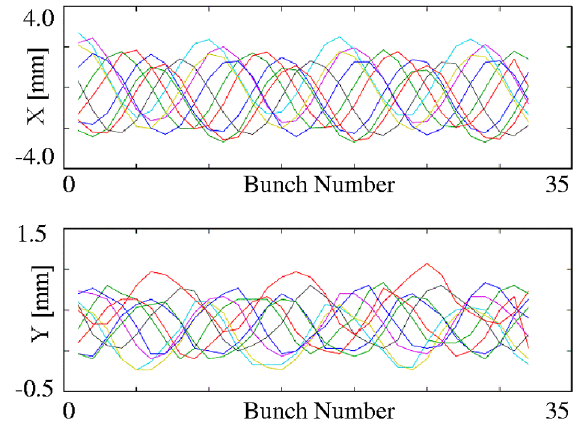
FIG. 11. (Color) Deflection measured for the different optics setting.